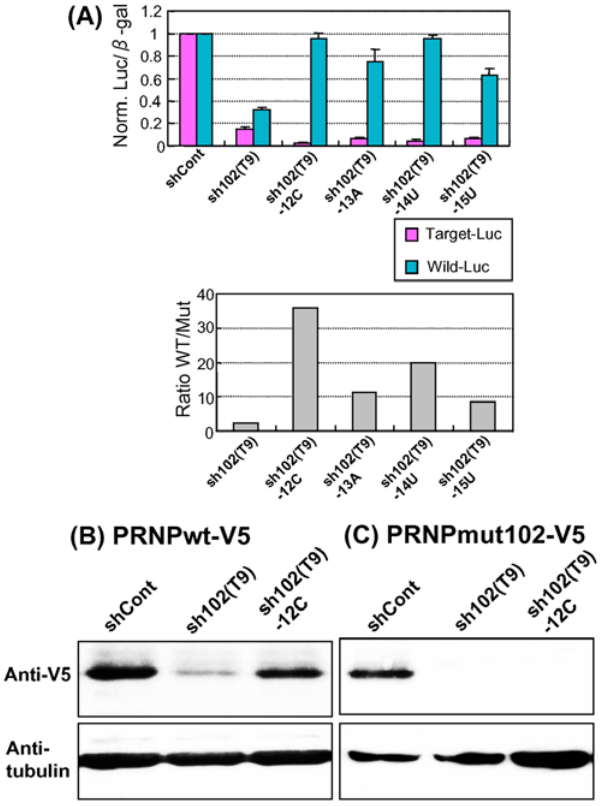
sh102(T9)-12C, sh102(T9)-14U, sh102(T9)-15U and shCont shRNA expression plasmids for production of siPrnp102(T9), (T9)-12C,